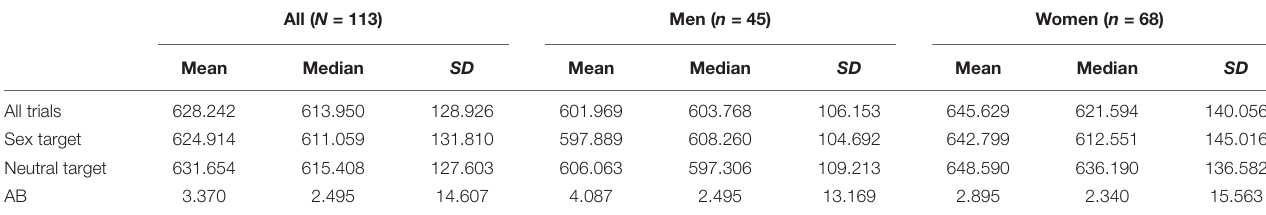
TABLE 1 | Dot-probe task: Mean RT (ms), median, and SD